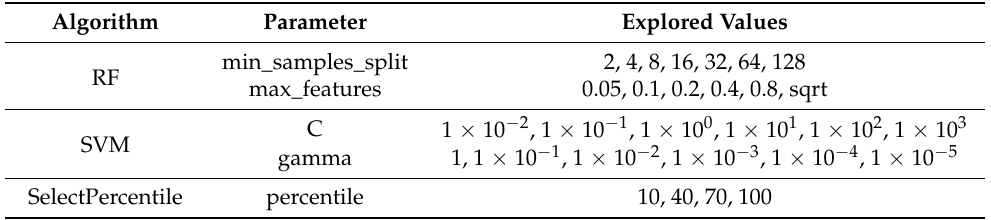
Table 9. Hyperparameter ranges explored by grid search during model